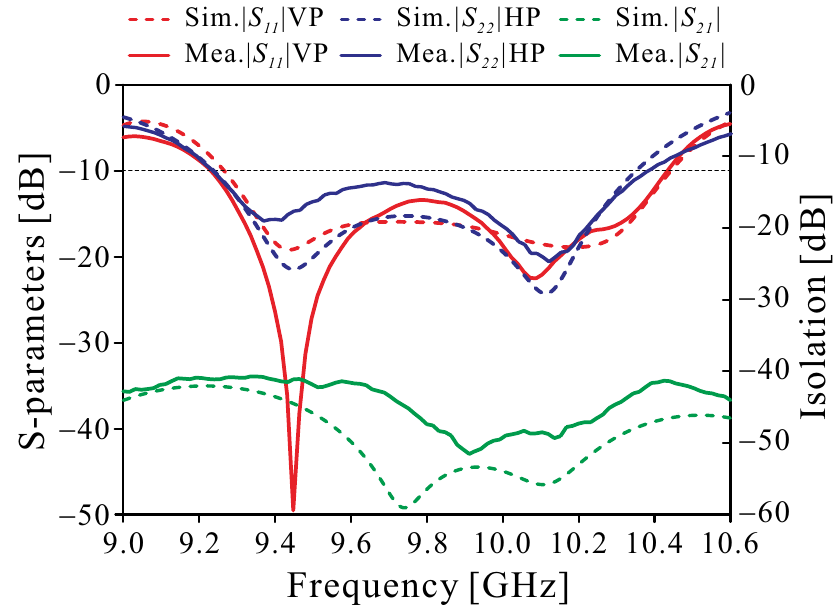
Figure 11. The S-parameters and isolation of the dual-polarized antenna array.